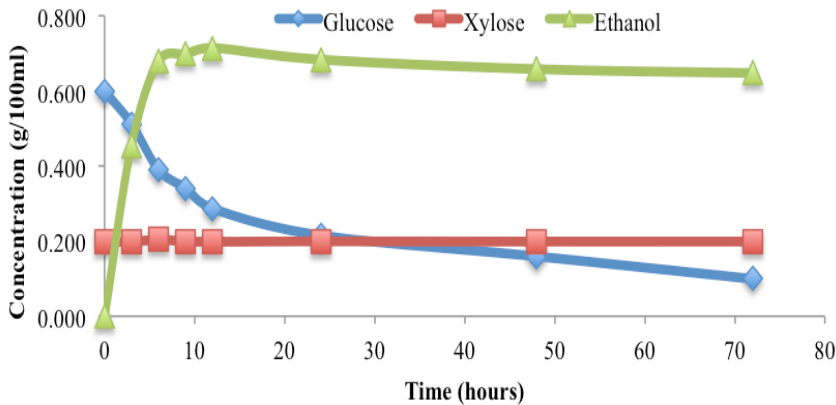
Figure 5. Ethanol, glucose and xylose profiles during the saccharification and fermentation (SSF) of the MxG cake.